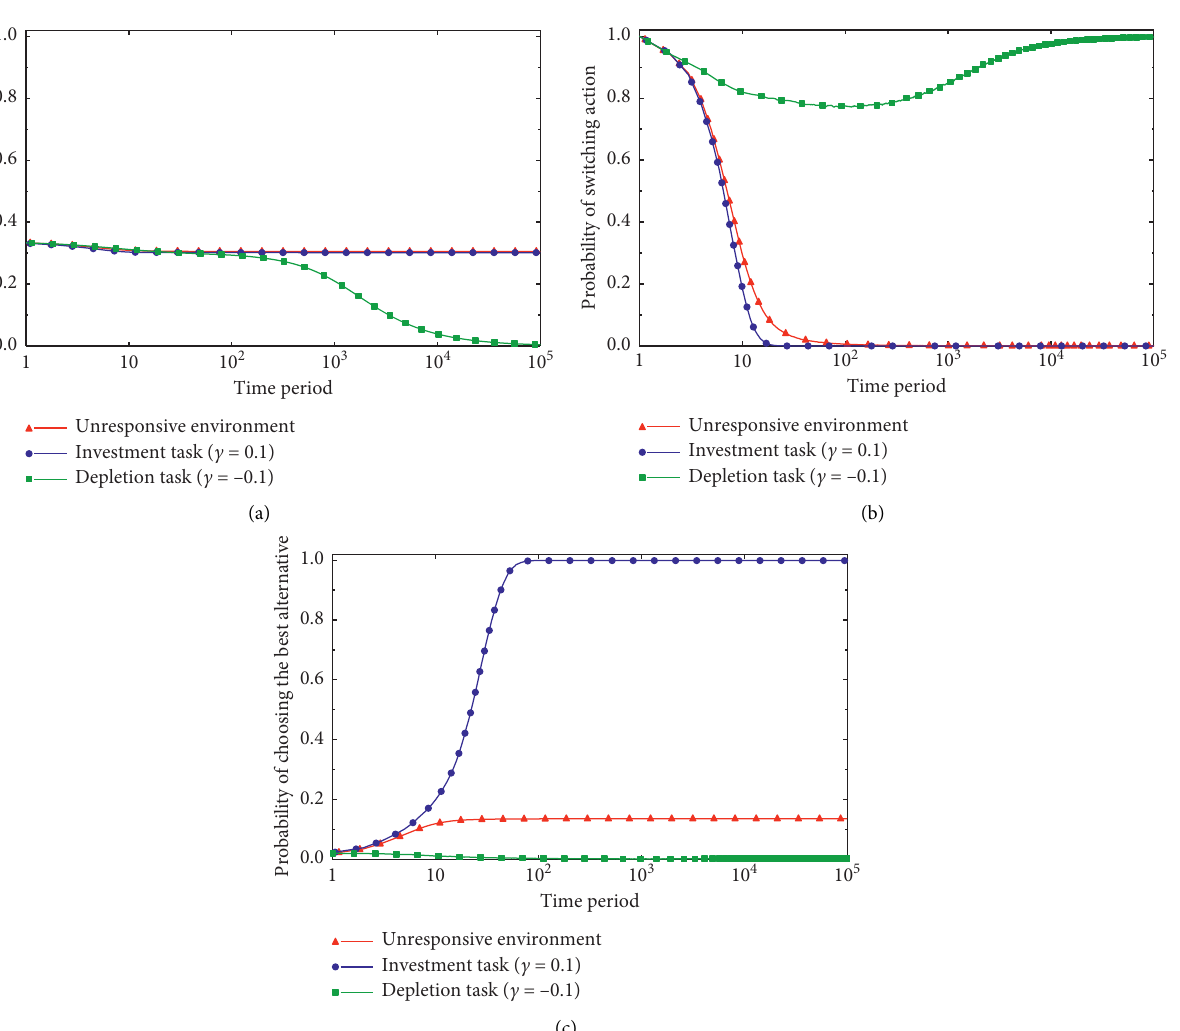
Figure 6: (a) Degree of biased beliefs (i.e., the distance between belief and reality), (b) probability of switching action, and (c) probability of choosing the best